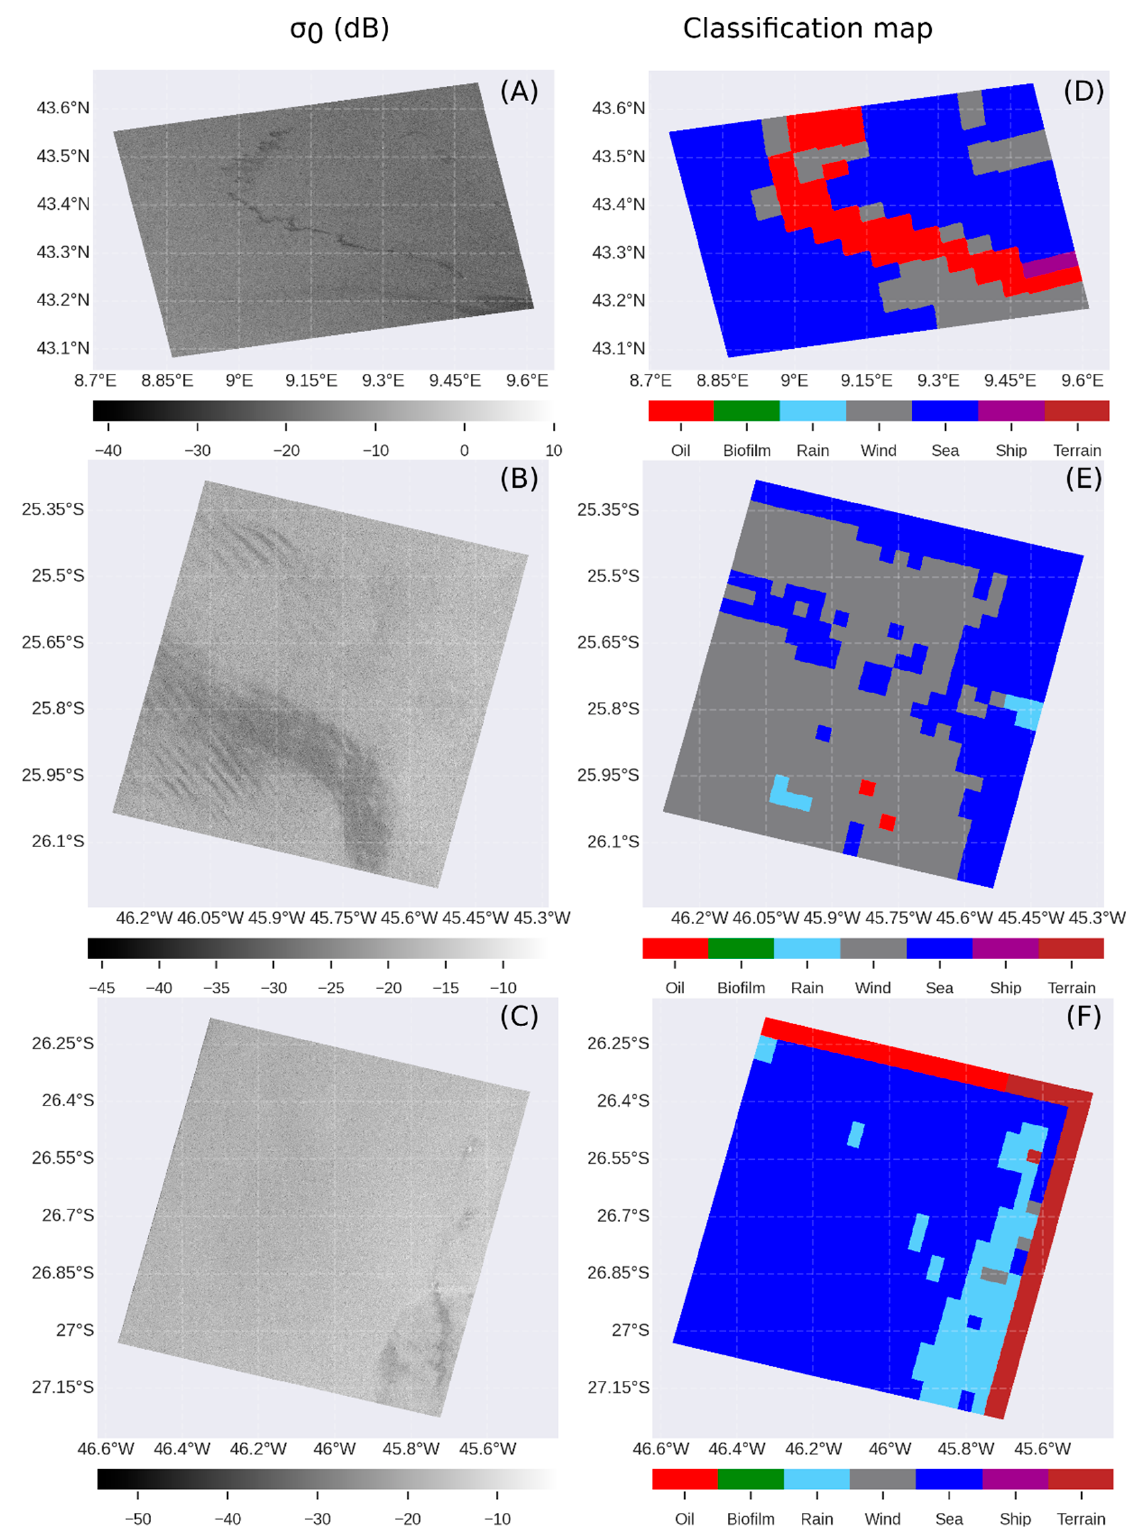
Figure 8. Oil spill ( A ), wind ( B ), and rain cell ( C ) images and their associated classified blocks as calculated from a 7-class random forest model in ( D ), ( E ), and ( F ).